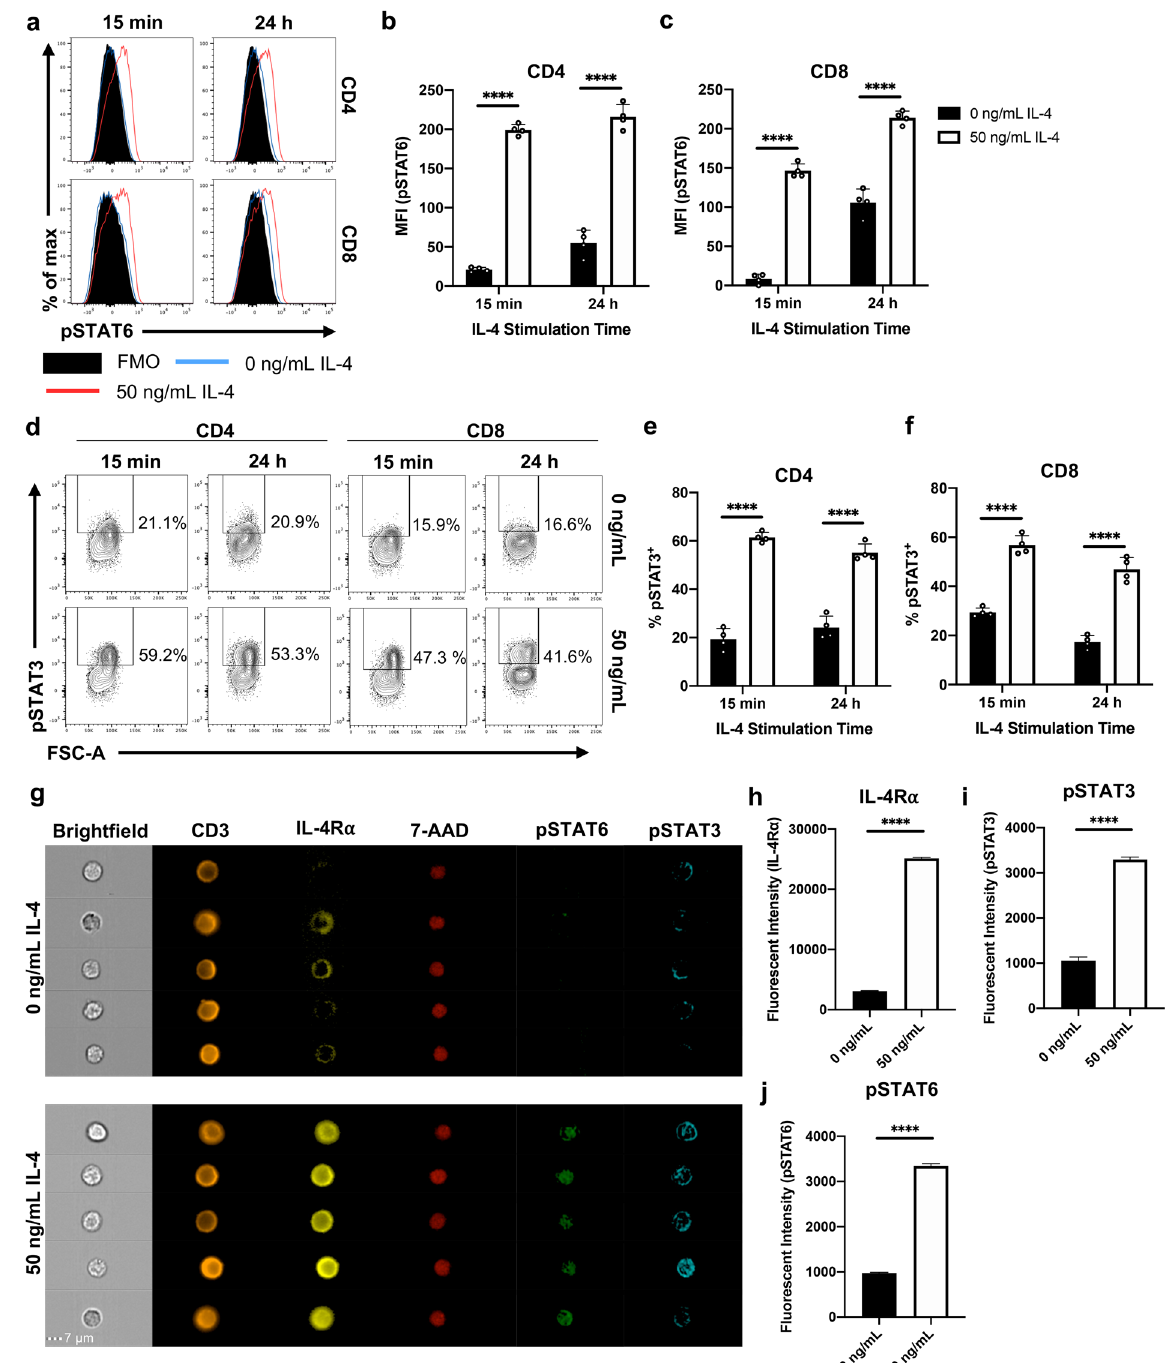
Figure 3. IL-4 stimulation promotes phosphorylation of both STAT6 and STAT3 on T cells. Whole spleen homogenate derived from naïve 6–8-week-old female BALB/c mice ( n = 4) were stimulated with 50 ng/mL IL-4 in vitro for 15 min or 24 h prior to flow cytometric analysis. (a) Representative histograms show the expression of pSTAT6. MFI (pSTAT6) of both (b) CD4 and (c) CD8 T cells between treatment conditions. (d) Representative contour plots showing the expression of pSTAT3; since pSTAT3 expression was bimodal, MFI was not evaluated. The proportion of (e) CD4 and (g) CD8 T cells that were deemed pSTAT3 + . Data are represented as mean + SD, with dots representing biological replicates from a single experiment. The experiments were repeated three times. Two-way ANOVA combined with Tukey’s post-hoc multiple comparison test was conducted to compare groups. (g) Whole spleen homogenate derived from naïve 6–8-week-old female BALB/c mice were stimulated with 50 ng/mL IL-4 in vitro for 24 h prior to ImageStream analysis. Representative images of pre-gated total T cells. Note that cells were fixed, allowing 7-AAD to be used as a nuclear stain. The fluorescent intensity of (h) IL-4Ra, (i) pSTAT6 and (j) pSTAT3 were compared between treatment groups. Data are represented as mean + SEM, where n > 1200 from a single experiment. The experiment was repeated three times. Student’s t-tests were conducted to compare groups. p -value denotation: ‘****’ p <